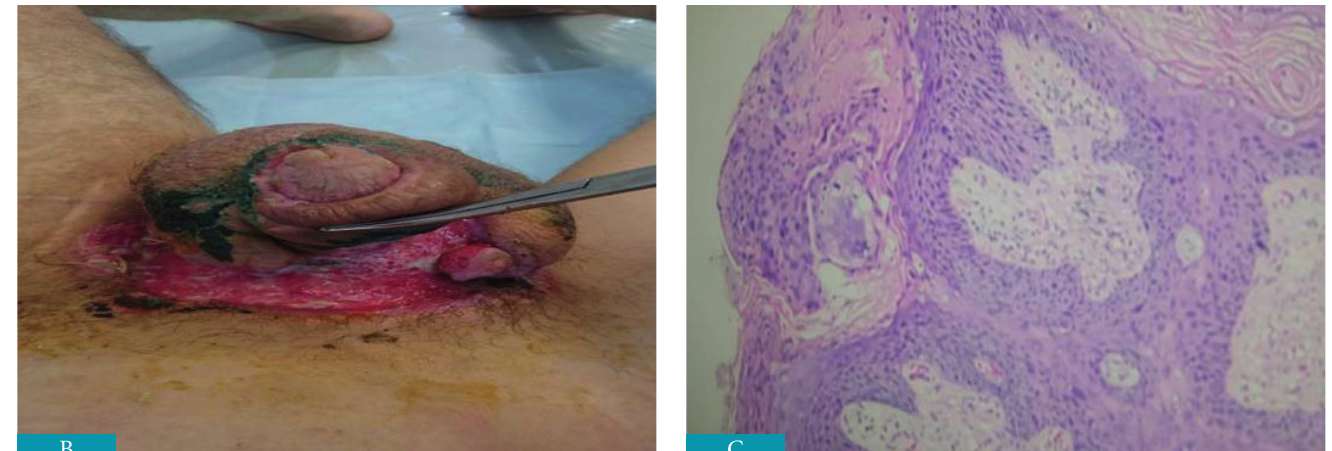
Figure 4 - A-view after local wide excision and closure of skin defect using local fascio-cutaneus flap. B-view after